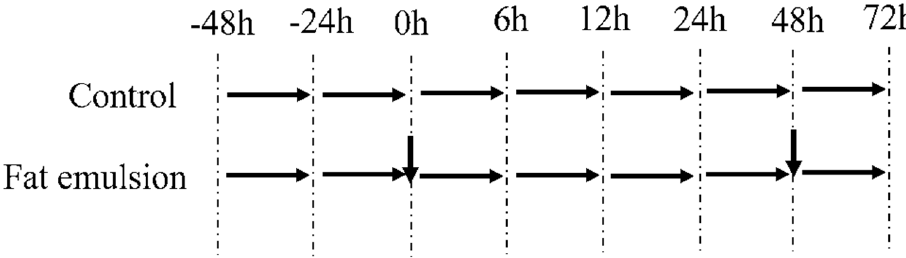
Figure 1. Determining optimal conditions in terms of viability for steatosis induction in primary broiler hepatocytes incubated with fat emulsion. The first downward arrow (0 h) indicates where culture medium was replaced with steatosis induction medium containing 2.5, 5, 10, or 20% fat emulsion. The second downward arrow at 48 h indicates where the medium in the fat emulsion group was replaced with fresh induction medium. Viability was determined by CCK-8 assay at 0, 6, 12, 24, 48, and 72 h.